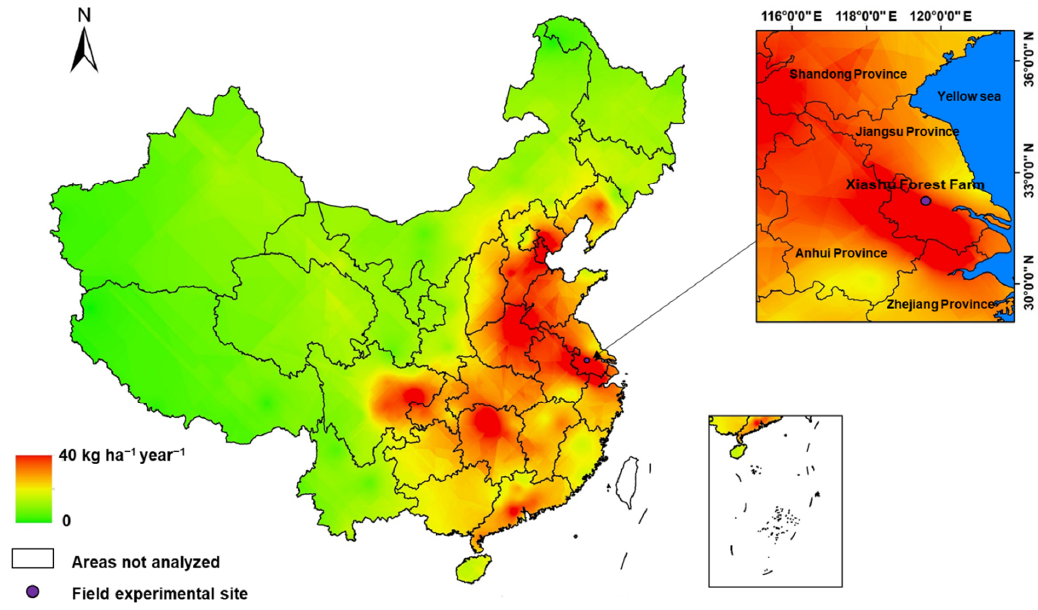
Figure 1. Spatial distribution of atmospheric inorganic nitrogen wet deposition in China from 2011 to 2015, and the location of the field site in Jiangsu Province, China. Data of